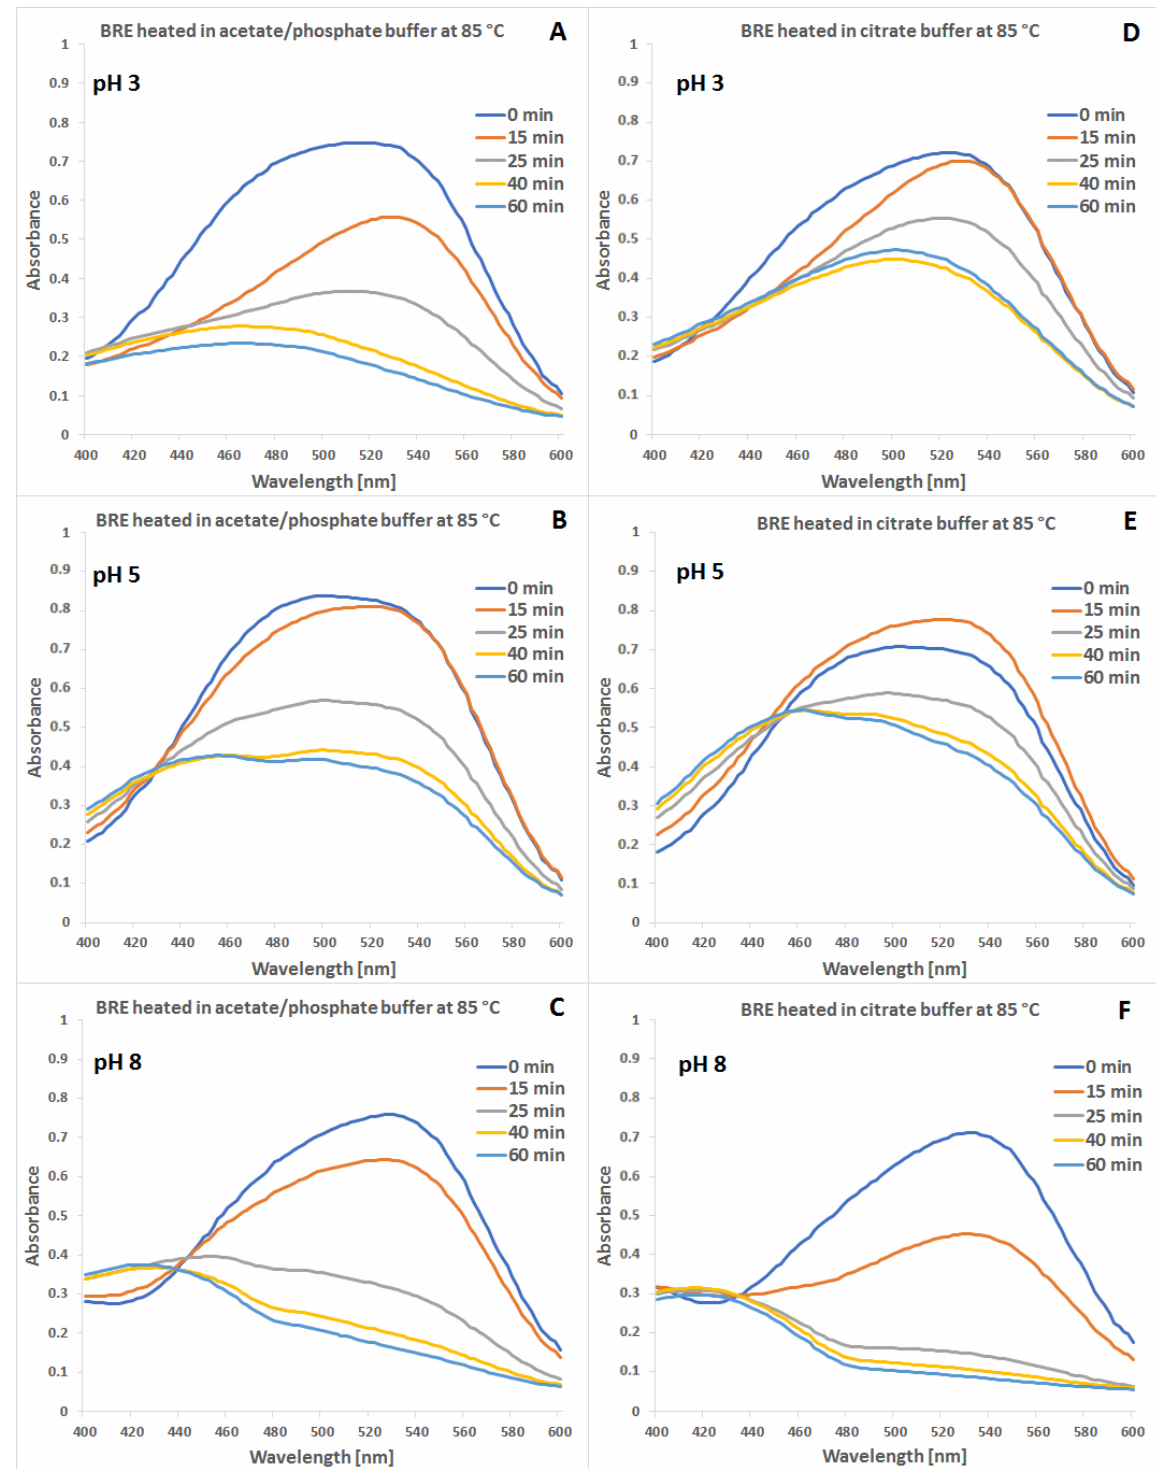
Figure 2. Visible spectra of betalain-rich extract (BRE) samples collected during their heat processing at 85 ◦ C in acetate/phosphate ( A – C ) and citrate buffers ( D – F ) at pH 3, 5 and